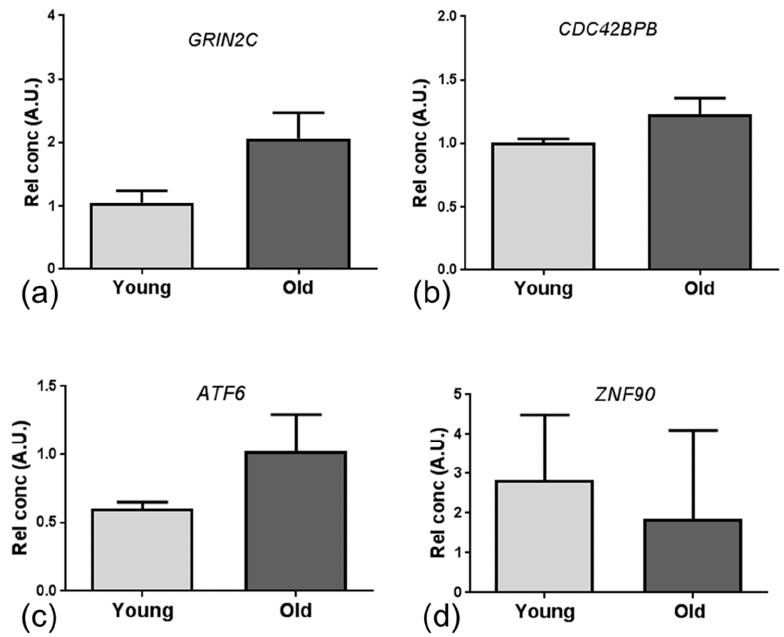
Figure 4. qPCR for mRNA validation of gene expression. A non-significant increase in ( a ) GRIN2C ( p = 0.078), ( b ) CDC42BPB ( p = 0.142), ( c ) ATF6 ( p = 0.056) and a non-significant decrease in ( d )